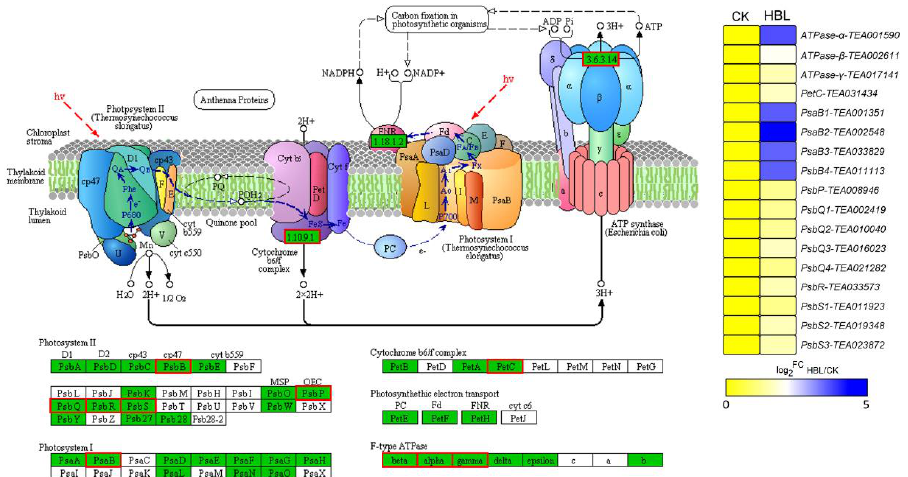
Figure 5. DEGs involved in photosynthesis under high intensity blue light in tea plant shoots. The pathway adapted from KEGG, the green box indicates the background genes of tea plant genome, and the red line indicates the annotated DEGs. The heatmap was generated from the log 2 -fold change (log 2 FC) mean value calculated from three replicates of RNA-Seq data.